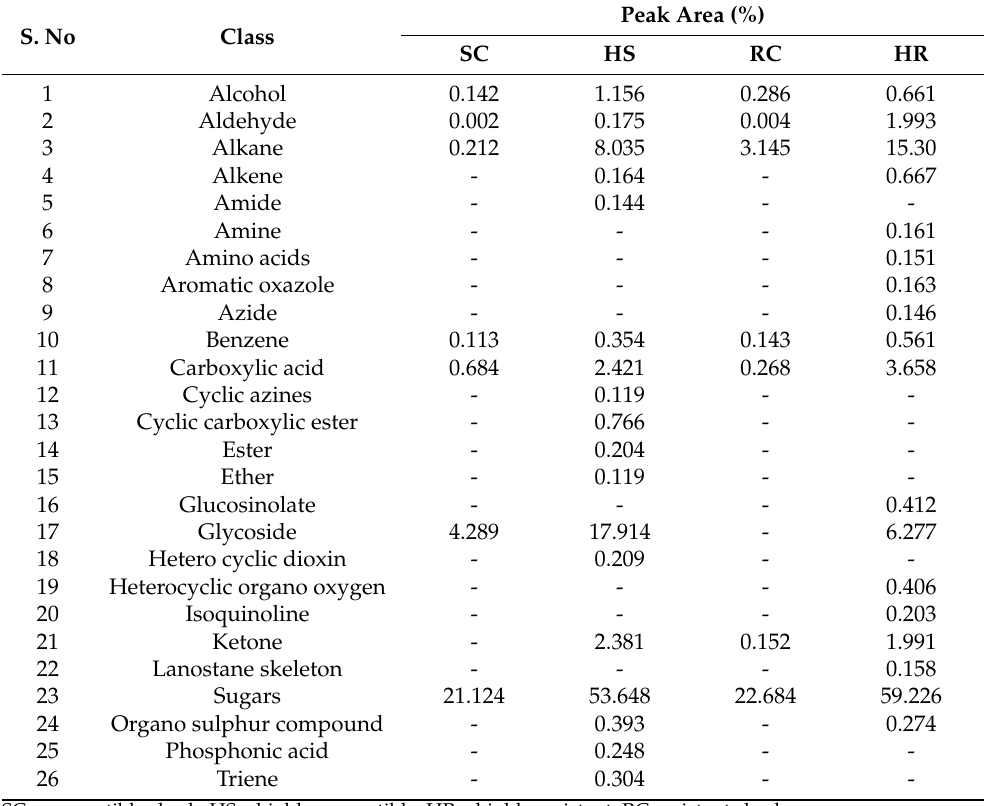
Table 3. List of differentially expressed biomolecules consequent to HgYMV infection in horse gram. S. No